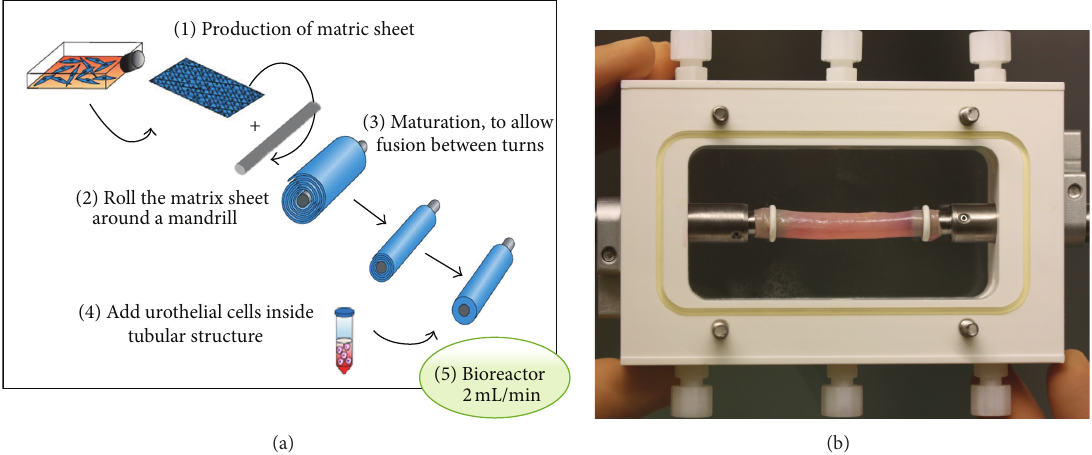
Figure 3: Production of cell-seeded tubular urethral graft using self-assembly technique. (a) After the production of a matrix sheet by fibroblasts, it is rolled to form a tube and urothelial cells are seeded in the lumen. (b) Bioreactor for tubular cell-seeded grafts to stimulate differentiation and formation of watertight mucosal layer.